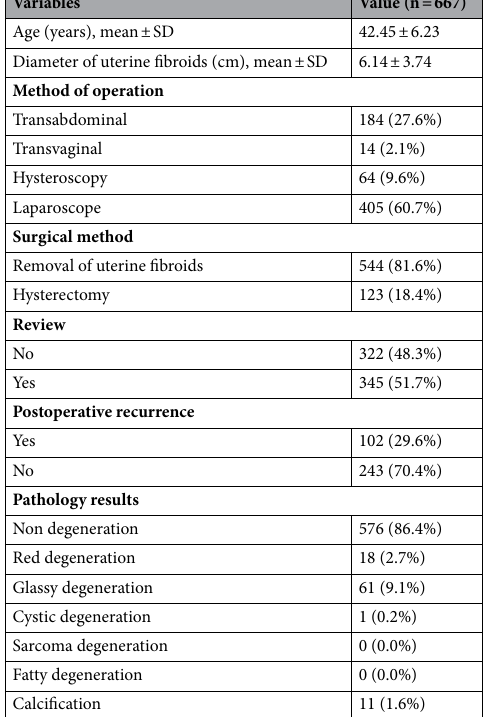
Table 1. Clinical and pathological data summaries of the patients. Except where indicated, the data are numbers of patients with percentages in parentheses. SD Standard deviation.